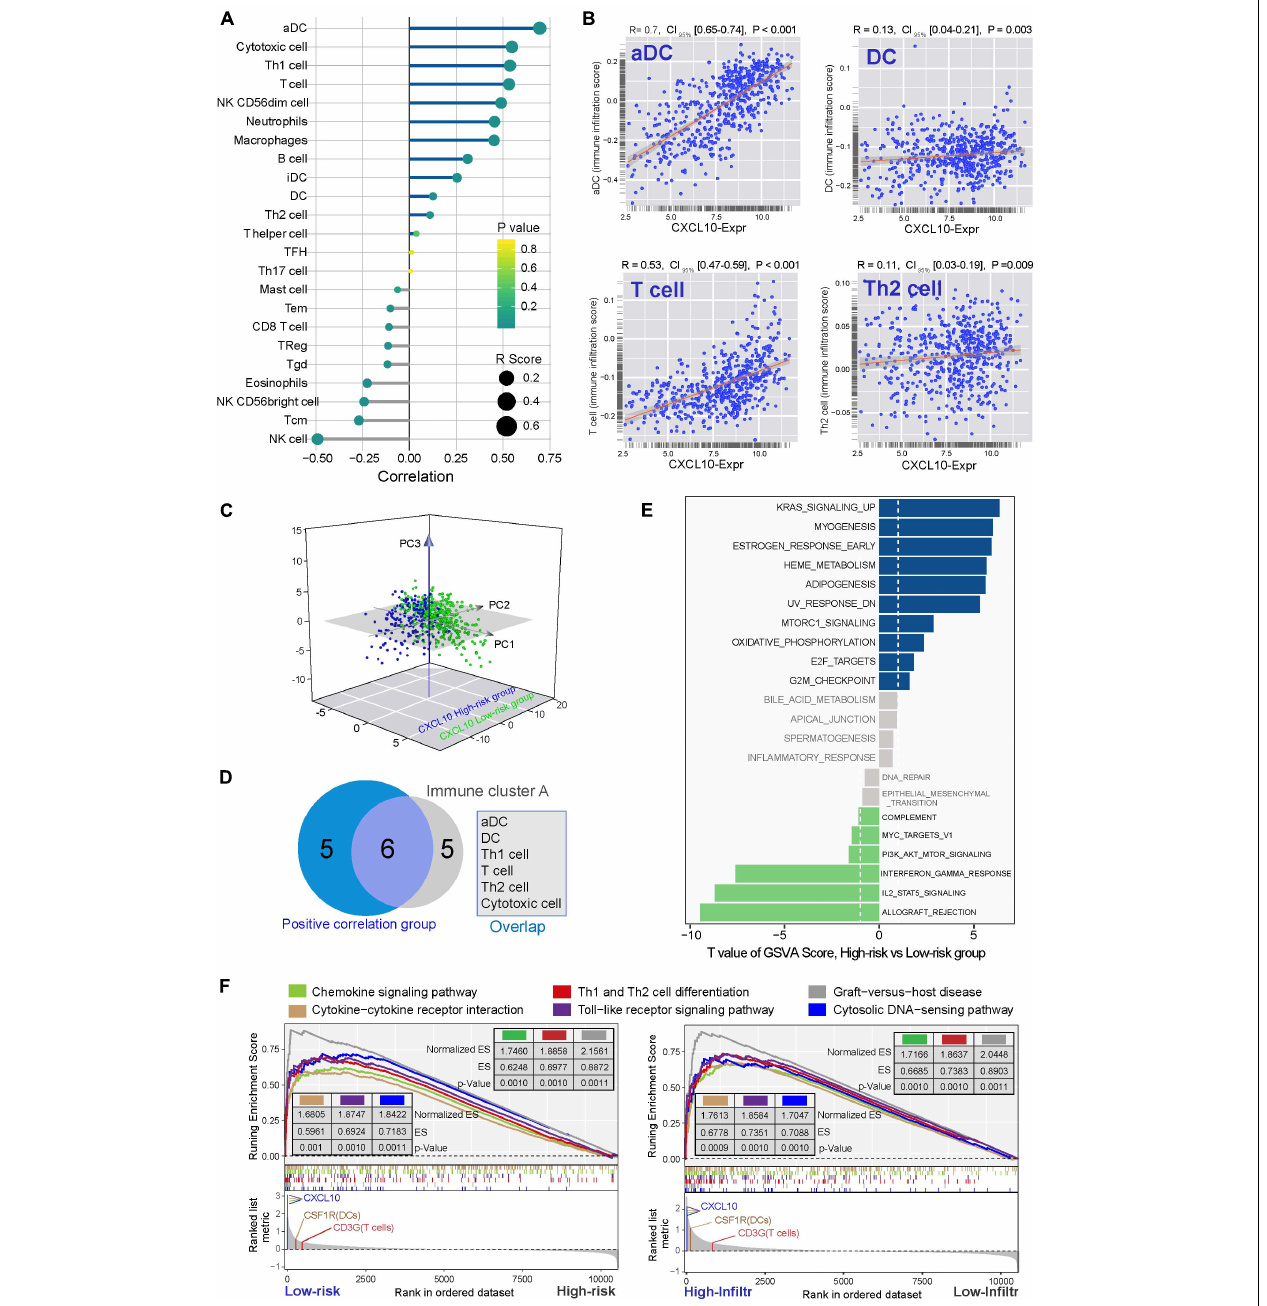
FIGURE 3 | TME immune cells transcriptome traits in TCGA-Ovarian Cancer. (A) Correlation between CXCL10 and known TME immune cell infiltration in standard cohort was analyzed by Spearman. Positive correlation was marked with right arms (blue), and negative correlation was marked with left arms (gray). The circles size and color were represented the R score and P value. (B) Scatter plots depicted the positive correlation between CXCL10 expression and four particularly interested immune cells. (C) Venn diagram showed the overlap of immune cells between immune cluster-A and CXCL10 positive correlation group. We filtered six cells to further analysis CXCL10-related underlying mechanism. (D) PCA was used for the expression profiles of high- and low-risk classifications to distinguish selected immune signature gene sets. These signature genes expression was well distinguished based on the different risk classifications. High risk classification marked with blue, and low risk classification marked with green. (E) Differences in pathway activities. The 135 selected immune signature genes expression between high-risk and low-risk classifications were analyzed by GSVA. T values are from a linear model, ultimately correcting the effects from the patient of origin. The KRAS signaling-up was marked in high-risk classification, and IL2-STAT5 signaling was marked in low-risk classification. (F) GSEA of the whole genome expression data from TCGA ovarian cancer in low- to high-risk classification and high- to low-infiltration patients. The enrichment results with immune associations between low-risk classification and high TME cells-infiltration are shown. P values were determined by using the Kolmogorov–Smirnov test.